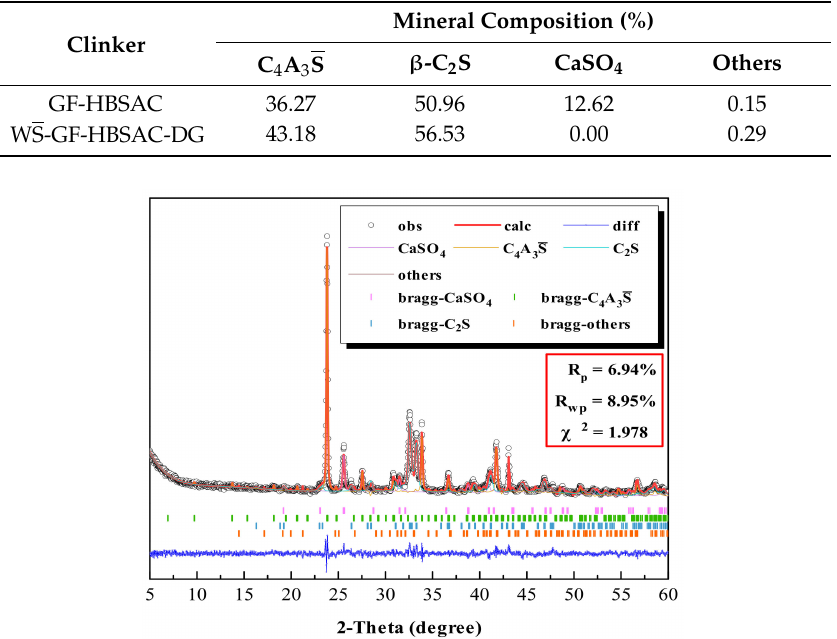
Figure 5. Refined X-ray di ff raction (XRD) pattern of GF-HBSAC clinker by using GSAS. In combination with the results of QXRD analysis, WS-GF-HBSAC-DG cement was prepared by mixing 84% WS-GF-HBSAC-DG clinker with 16% DG on the principle of equal CaSO 4 and C 4 A 3